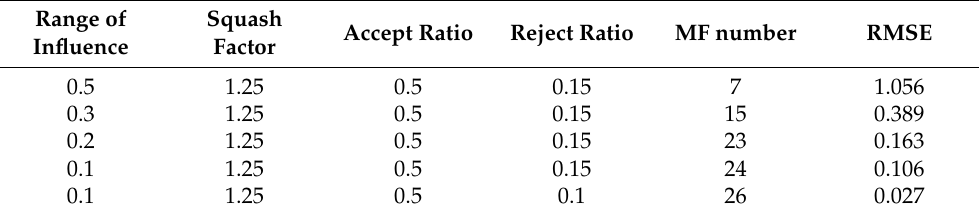
Table 1. Training parameters of subtractive